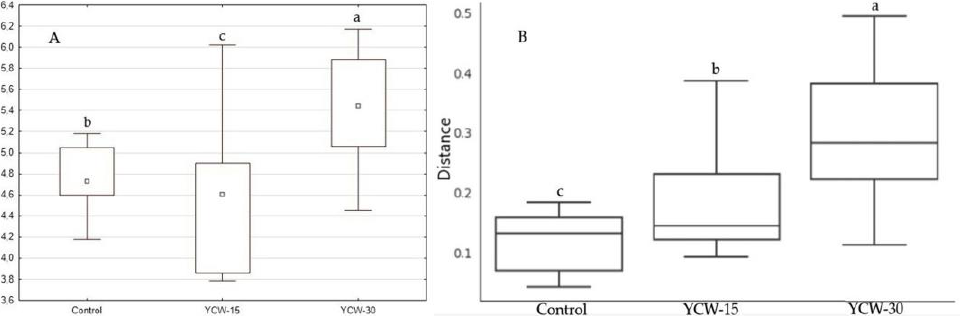
Figure 2. Microbiome alpha diversity ( A ) and beta diversity ( B ) of control, YCW-15, and YCW-30 groups. a,b,c Boxplots with the same letter are similar.